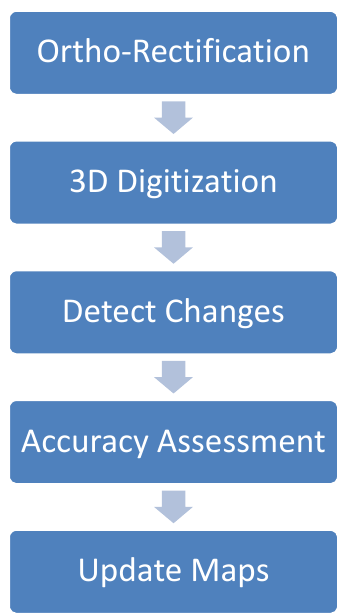
Figure 3. Methodology